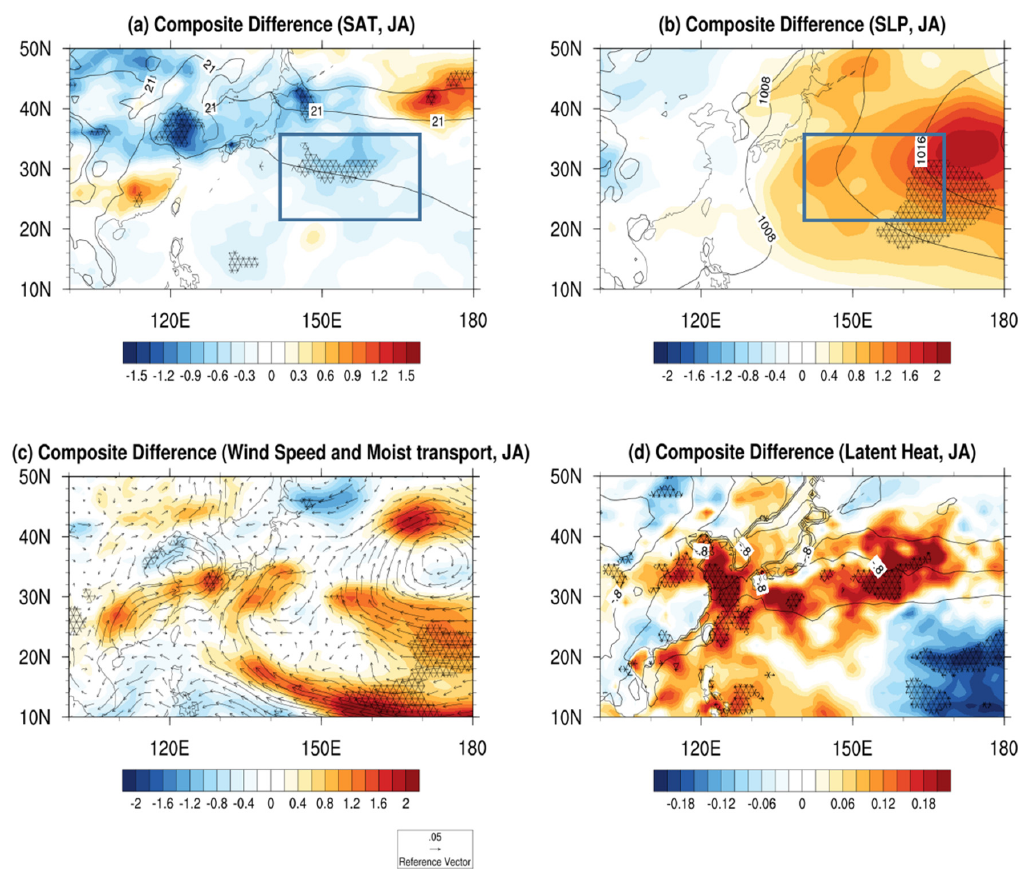
Figure 4. The composite difference between high AOD and low AOD of ( a ) JA surface air temperature (SAT; ℃ ), ( b ) JA sea level pressure (SLP; hPa), ( c ) JA wind speed (shading) (m/s) and moisture transport (vector) (kg*m/s), and ( d ) JA latent heat flux (10 − 6 J/m 2 ). Regions with black cross-hatching indicate a statistical significance at a 95% confidence level. Solid black lines denote the climatological (2000–2017) mean.